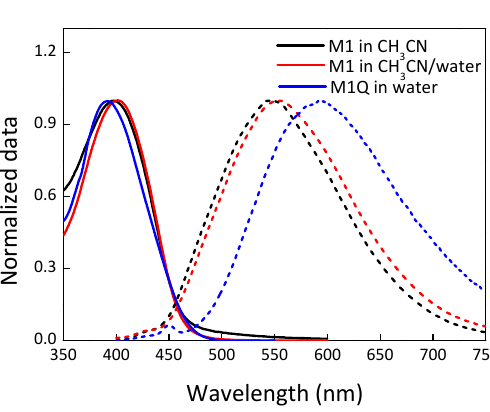
Figure 1. Normalized absorption (solid) and PL spectra (dash) of M1 and M1Q. Excitation at 390 nm. [M1] = [M1Q] =1.0 × 10 − 6 M.